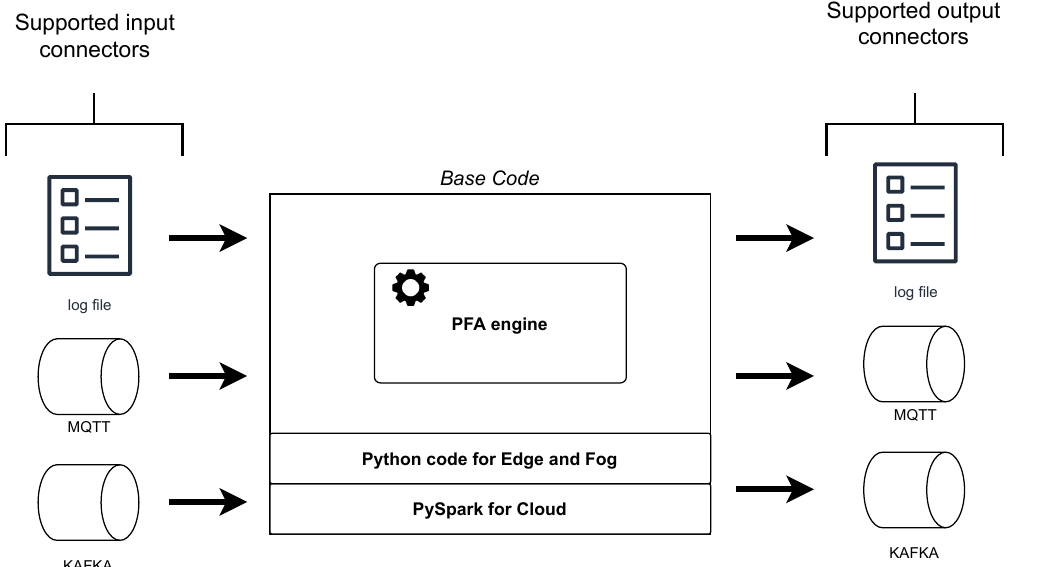
Figure 9. Base code created for deploying the models in streaming, alongside its different inputs and